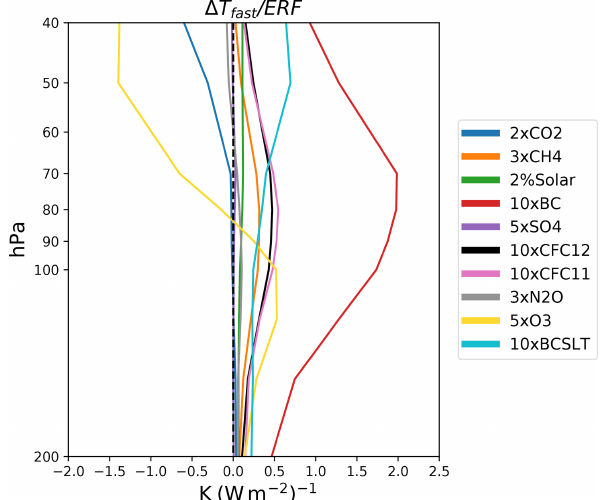
Figure 5. Profiles of fast temperature response normalized by ERF (K(Wm − 2 ) − 1 ) between 200 and 40hPa, averaged over 30 ◦ N– 30 ◦ S. The color coding indicates results from different perturba- tions. Each profile is the multi-model